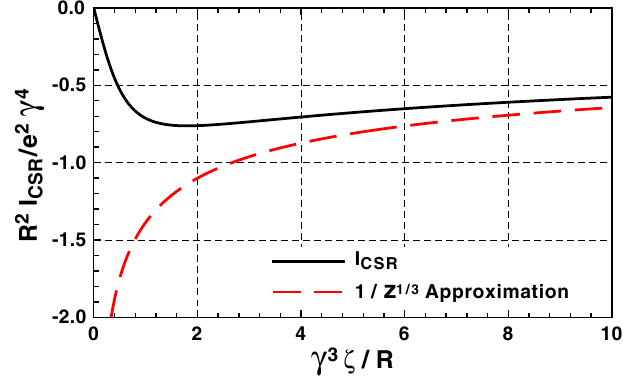
FIG. 3. (Color) I (cid:6) as a function of (cid:5) for a bend. The dashed CSR line is the large (cid:5) approximation as given in Eq.